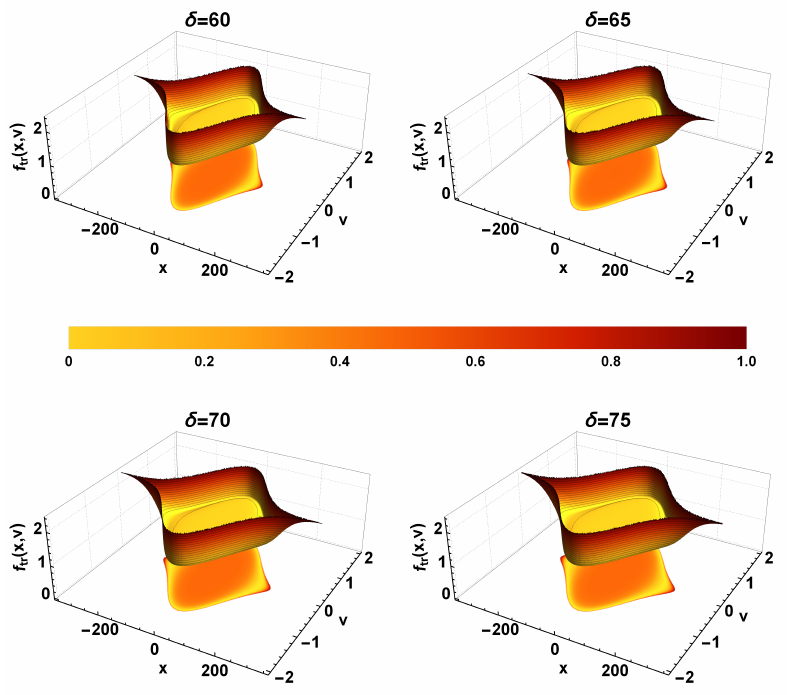
Figure 10. The trapped ion distribution function for different δ keeping T r = 3 and ψ = 3 as constants. The input amplitude represent Region 2. The central hump characterizes the phase space distribution for each